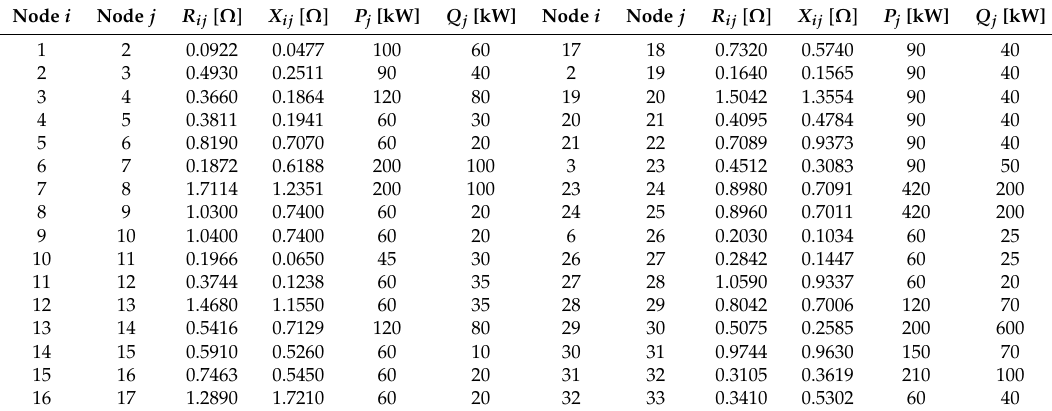
Table A1. Electrical parameters of the 33-node test feeder.